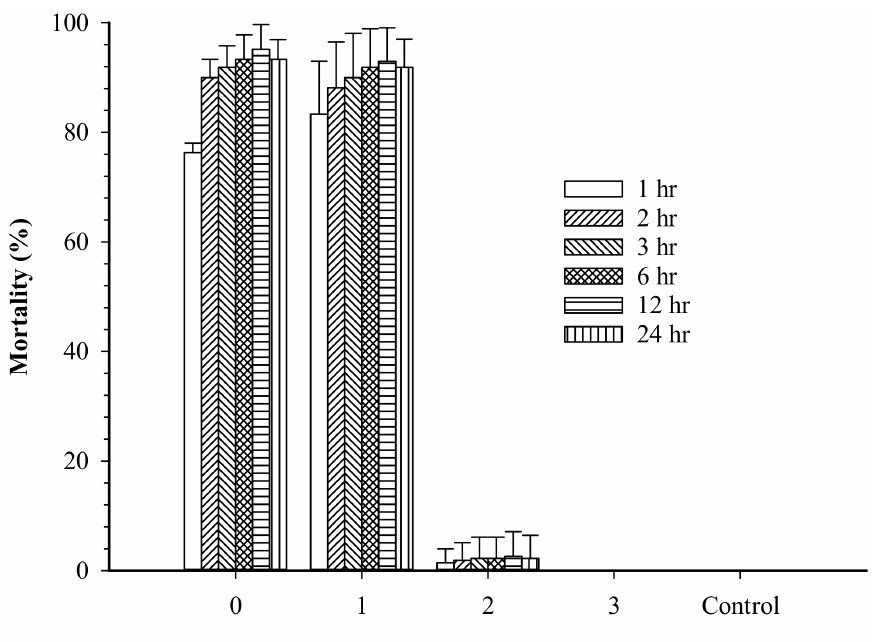
Figure 3. Residual activity of terahertz-based functional mineral water toward Aedes aegypti larvae. The Ae. aegypti larvae were transferred to a solution containing 250 ppm terahertz-based functional mineral water, which was prepared 3, 2, 1 days ahead and the day (0 days) of the experiment. Afterward, the mortality of larvae was recorded after 24 h. The control group was reared in RO-only water simultaneously. Data are presented as mean ± SE values from at least three independent